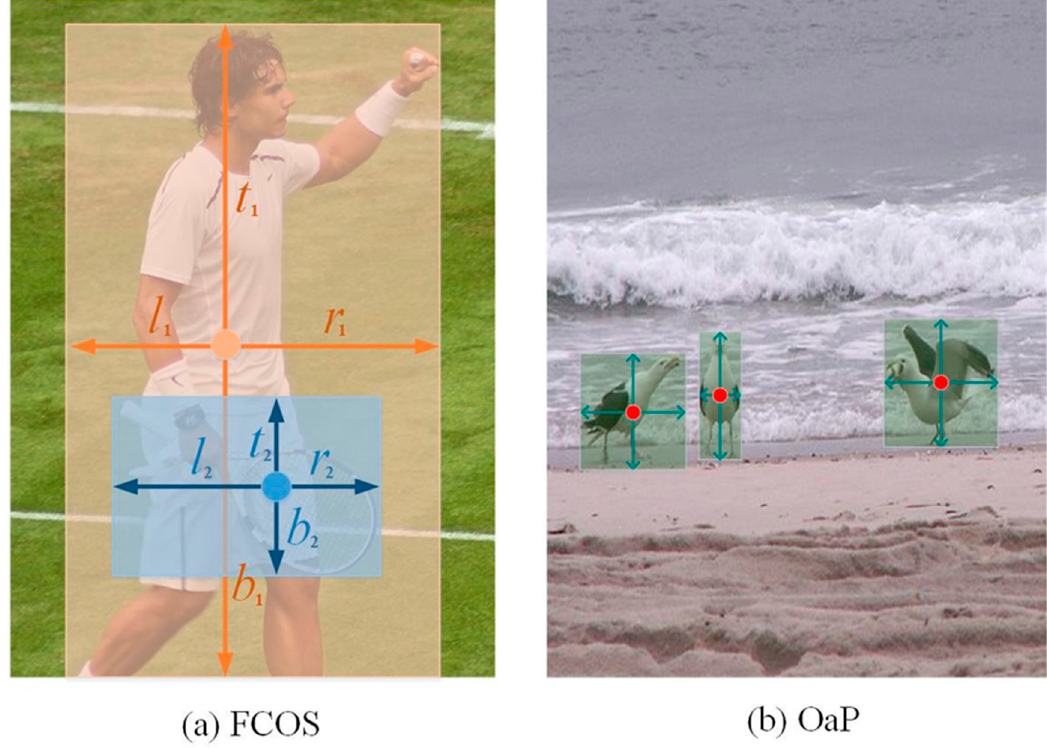
Figure 1. Detection effect of anchor-free algorithm. ( a ) Prediction of 4D vector by FCOS [13]. ( b ) Prediction of the center point by OaP [14]. The images are from the MS COCOtrain2017 dataset.